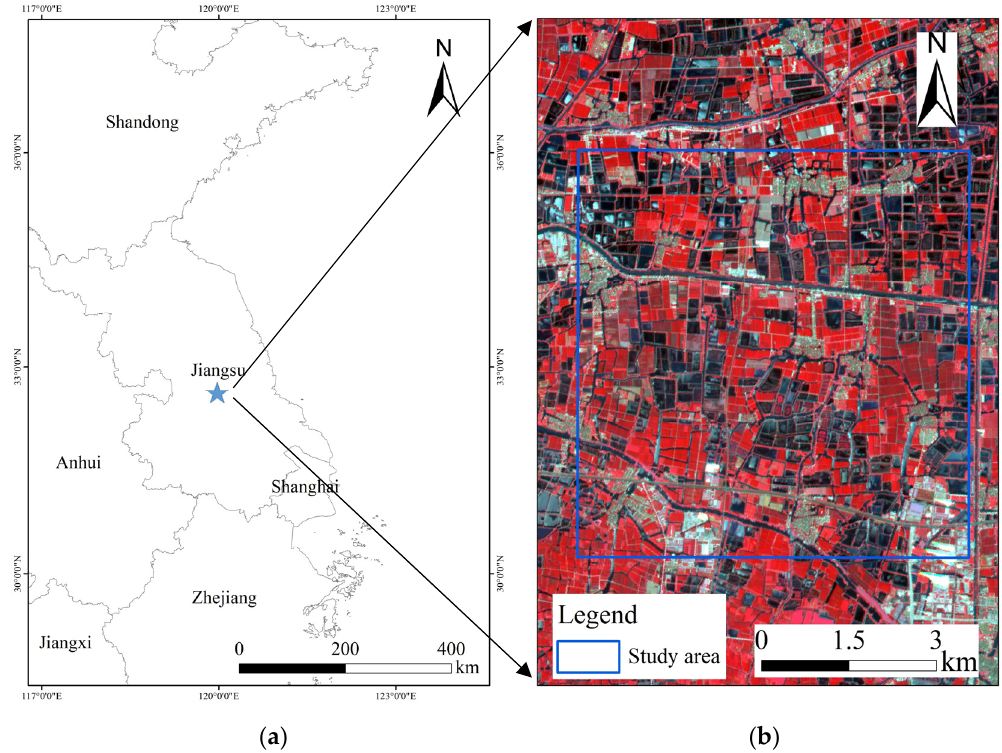
Figure 1. Location of the study area: ( a ) Location of the study site; ( b ) GF-1 PMS false-color composite image of the study area.